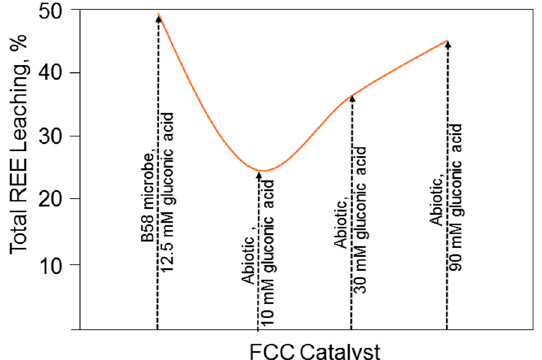
Figure 5. Leaching efficiency of total rare earth elements (REE) from fluid catalytic cracking (FCC) catalyst after 24 h using a four-day B58 culture supernatant producing 12.5 mM gluconic acid and abiotic solution of 10, 30 and 90 mM gluconic acid. Adapted from [36]. Copyright ELSEVIER, 2016.